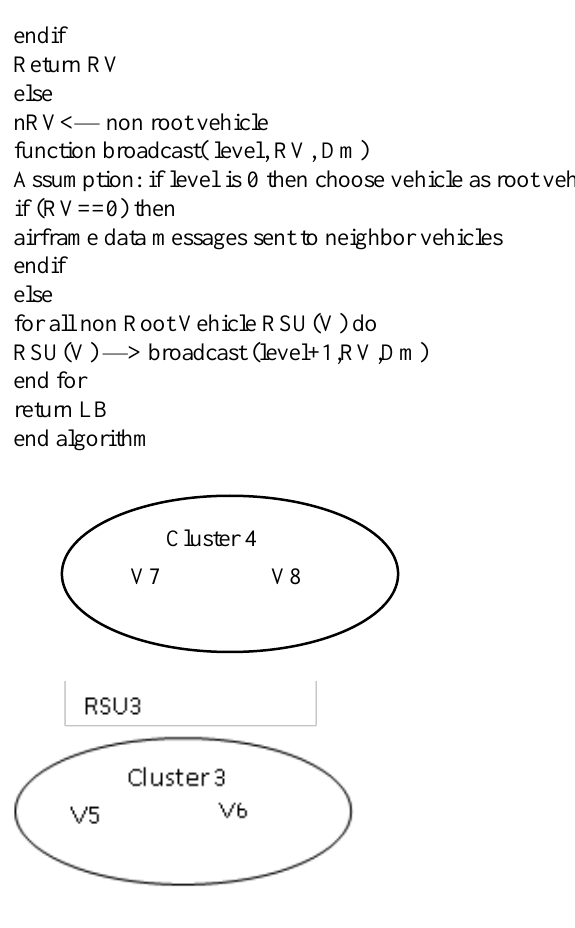
Figure 5. Integration of OMNeT, SUMO and Vein